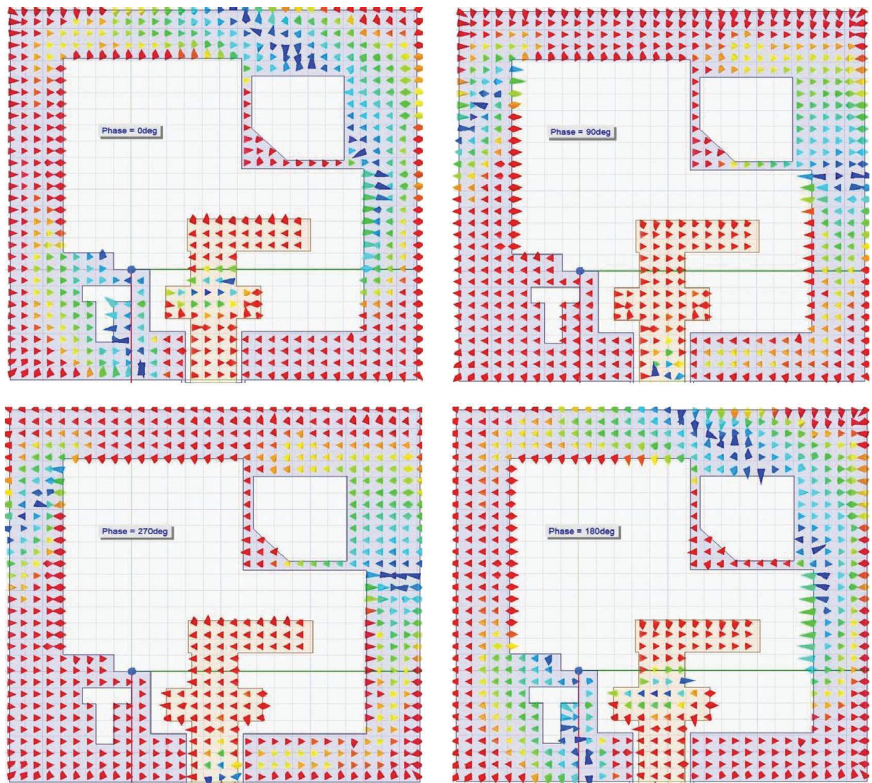
Figure 5: Circular polarization at